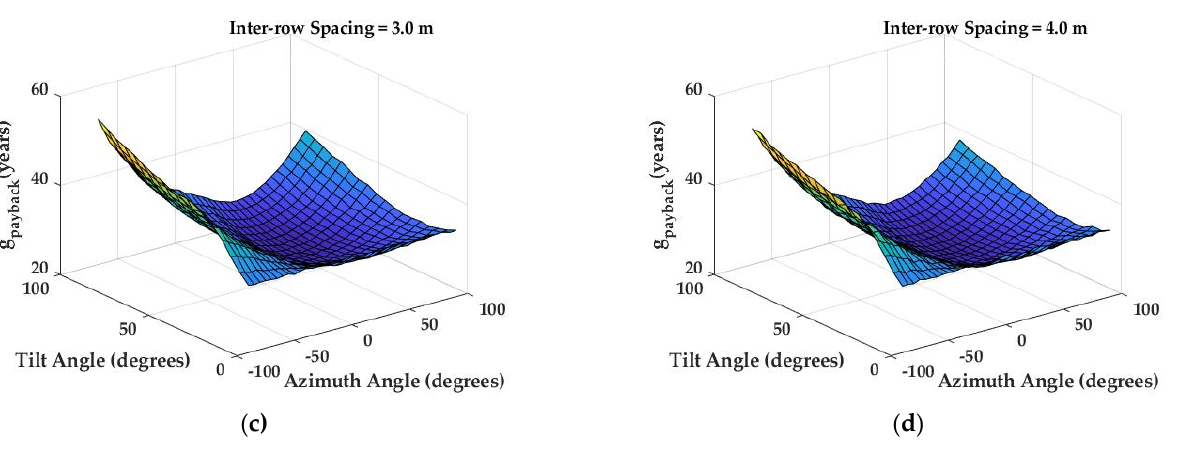
Figure 22. Objective function variation with tilt and azimuth angles for the EAS building for ( a ) L ir of 1.0 m, ( b ) L ir of 2.0 m, ( c ) L ir of 3.0 m, and ( d ) L ir of 4.0 m.